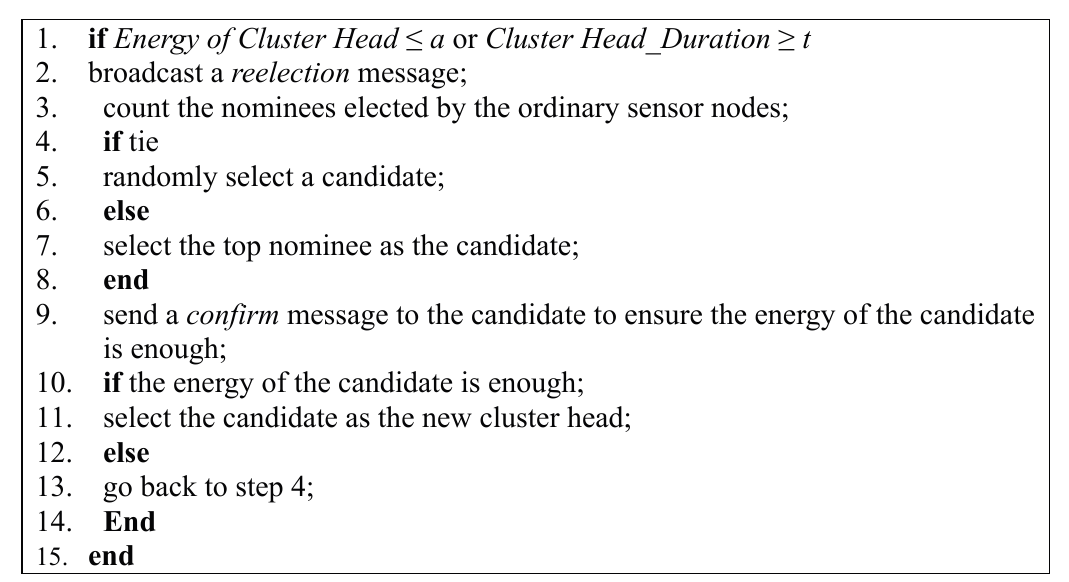
Figure 4. Procedure performed by cluster head.